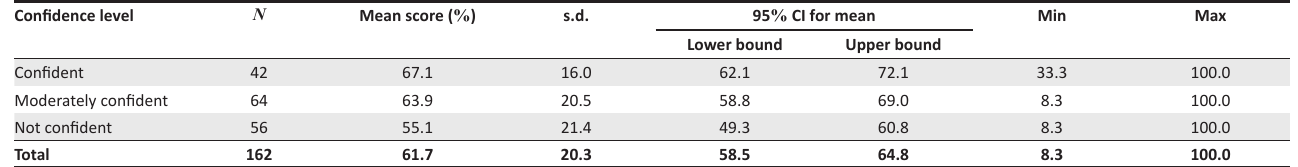
TABLE 4: Knowledge scores by doctor’s confidence level. Confidence